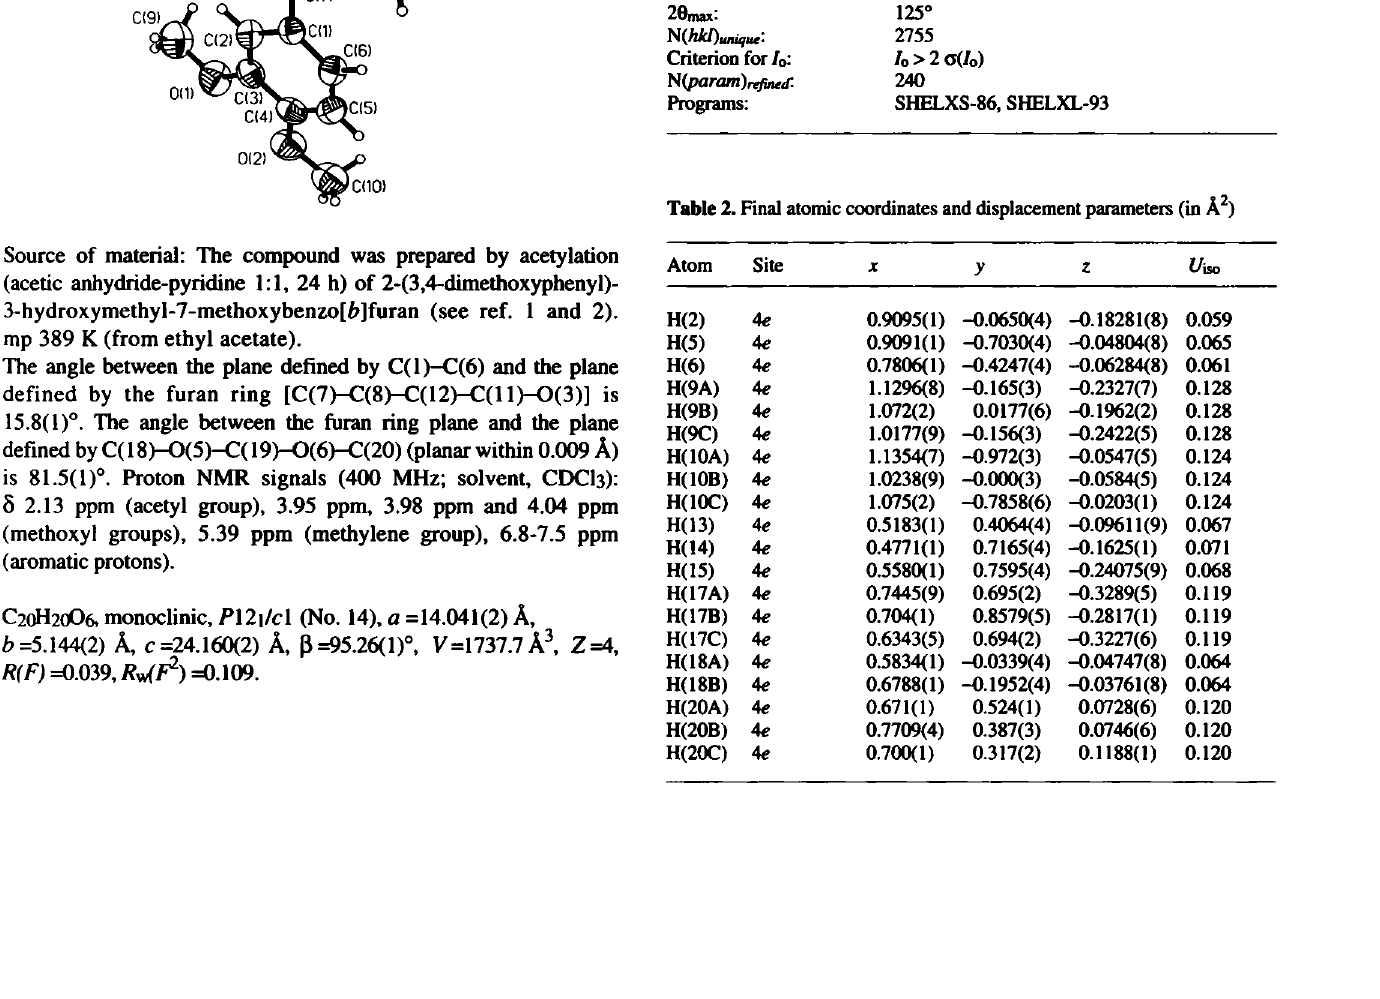
Table 1. Parameters used for the X-ray data collection